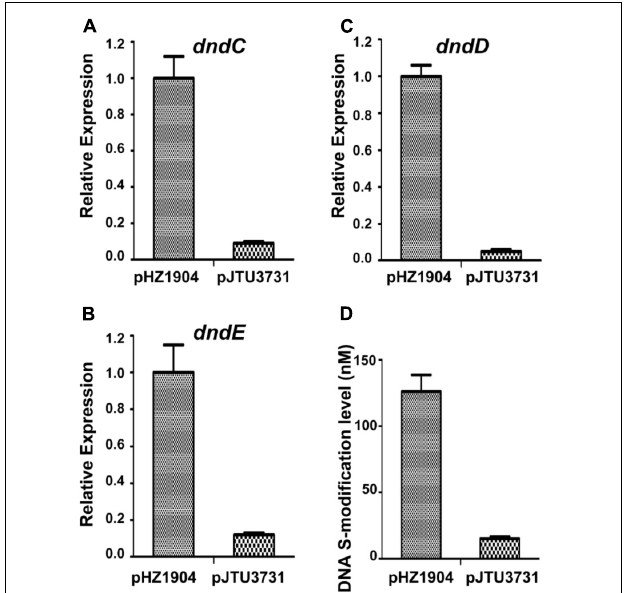
FIGURE 6 | The effects of R2 mutation on dnd gene expression and on DNA sulfur modification level. (A) The effect of R2 mutation on dndC gene expression. (B) The effect of R2 mutation on dndD gene expression. (C) The effect of R2 mutation on dndE gene expression. (D) The effect of R2 mutation on DNA sulfur modification level. pJTU3731, pHZ1904 derivative with R2 mutation. Three replicates were